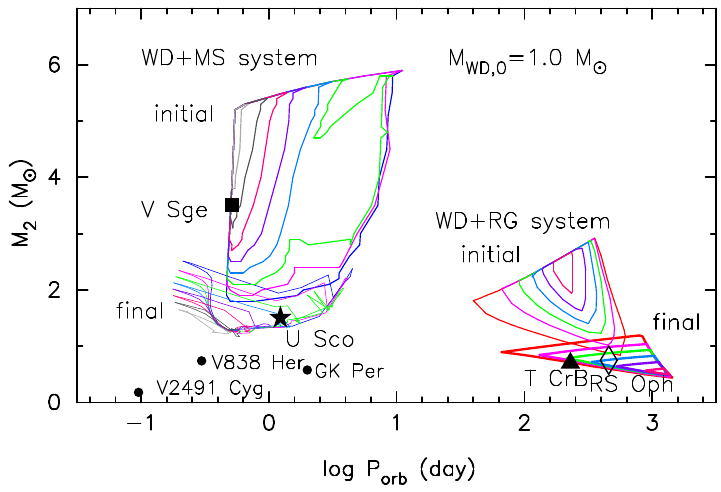
Figure 5: Initial and final binary parameter ranges for the SD scenario (taken from Hachisu et al. 2012). M 2 is the companion mass and P orb is the orbital period. An initial binary system inside the region encircled by a solid line (labeled initial) evolves to explode as a type Ia supernova when it reaches within the region labeled final. The recurrent novae U Sco and T CrB are located inside the final region, whereas the classical novae V2491 Cyg, V838 Her, and GK Per lie outside. Most classical novae and cataclysmic variables are located much below the left-side final